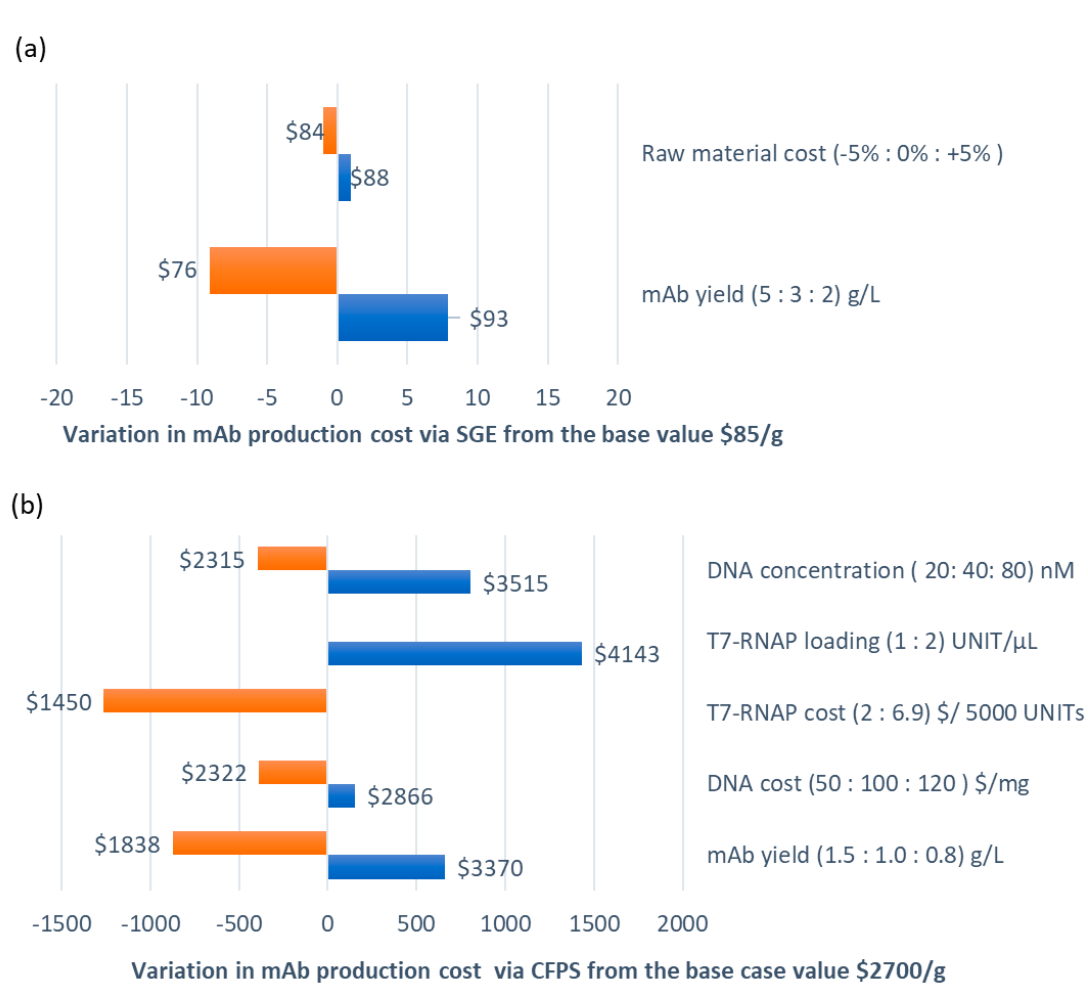
Figure 1. Sensitivity analysis of the mAb production cost for large-scale manufacturing, 200 kg mAb/year via ( a ) SGE, base case mAb production cost = $85/g and ( b ) CFPS, base case mAb production cost = $2700/g.